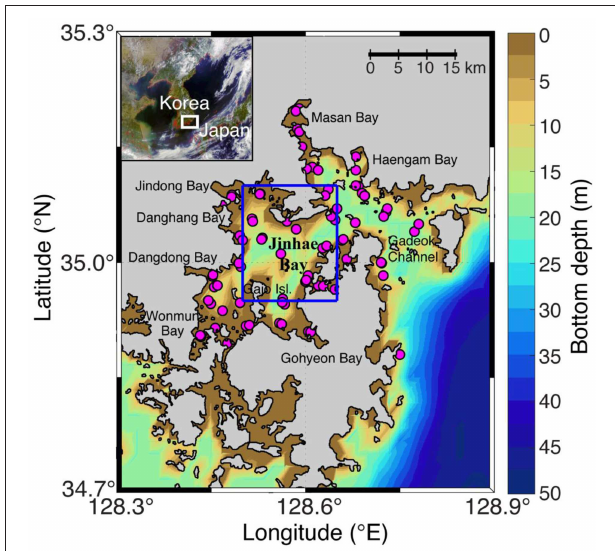
FIGURE 1 | Study area and field station locations in Jinhae Bay, Korean Peninsula. Inset map shows the GOCI RGB color composite (680/555/412nm) image on 20 May 2015, processed using the GDPS. Purple circles mark the locations of the in situ Chl-a observations. The blue box marks the area subjected to the time series analysis presented in Figure 8 . The color bar represents the bottom topography (m) from the ETOPO1 ( Amante and Eakins,